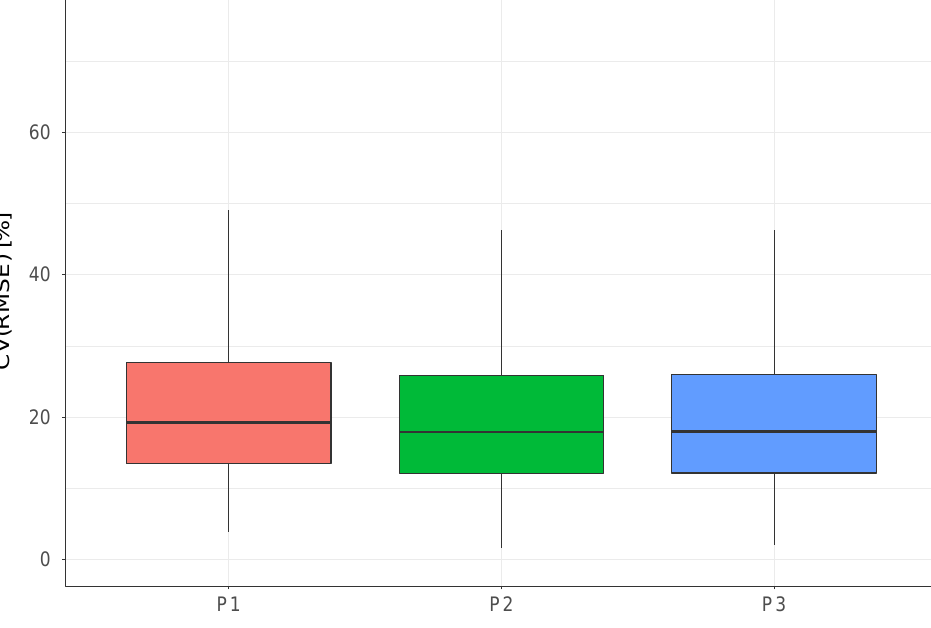
Figure 3. CV(RMSE) results obtained in Phases 1, 2 and 3 of model